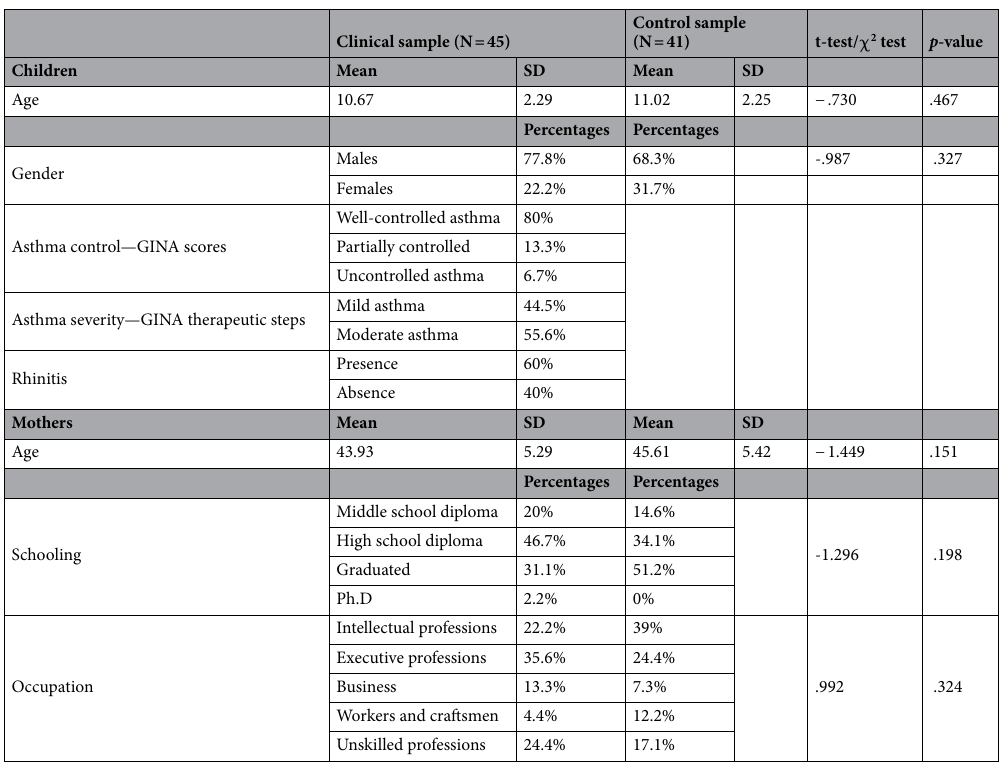
Table 1. Demographics and descriptive characteristics of children and mothers of the clinical and control groups. Student’s t-tests for continuous variables and χ 2 tests for dichotomic variables to compare the two groups. All results are reported as mean (SD), or with the percentage where